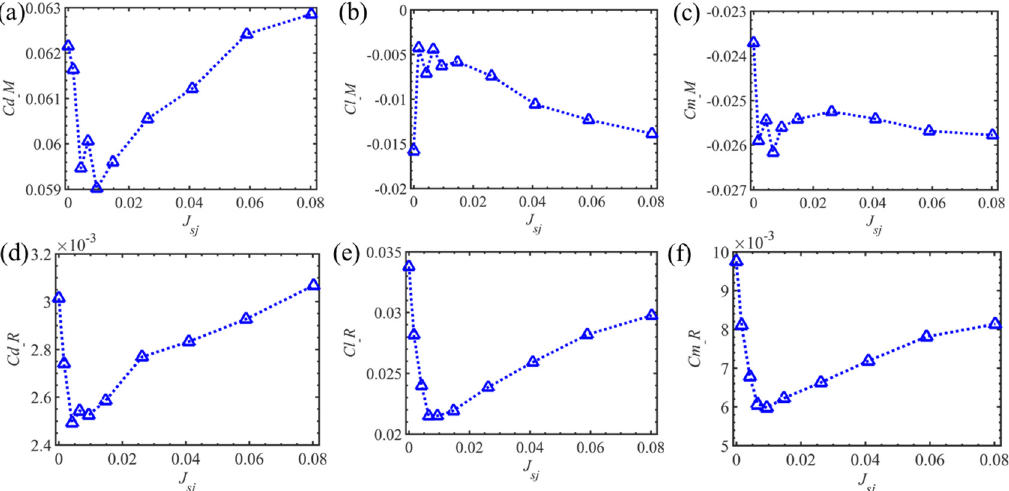
Figure 5. Aerodynamic forces that are acting on the SBG model. The mean value of the drag coefficient ( a ), lift coefficient ( b ), and moment coefficient ( c ). The fluctuation of the drag coefficient ( d ), lift coefficient ( e ), and moment coefficient ( f ).